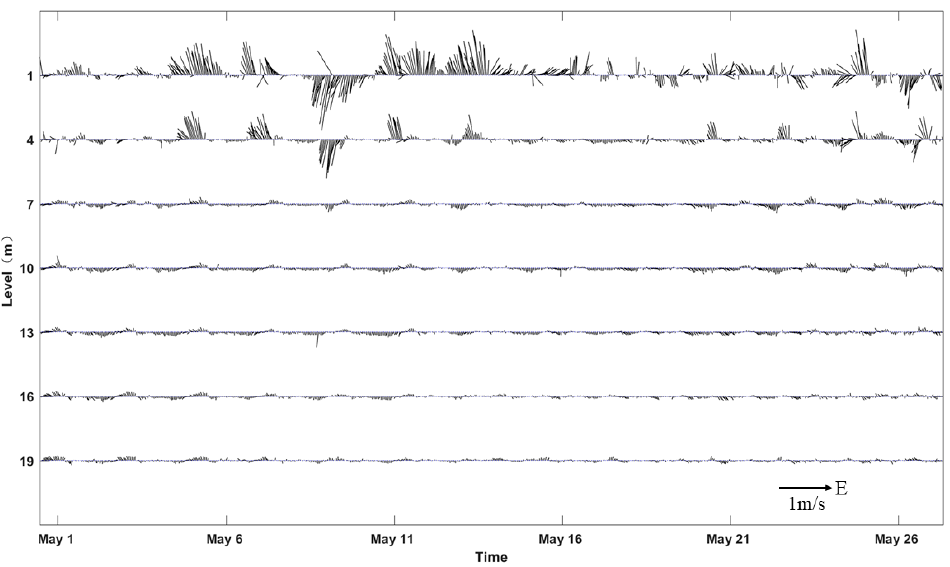
Figure 7. The monthly average tidal residual current of the profile in May 2021.